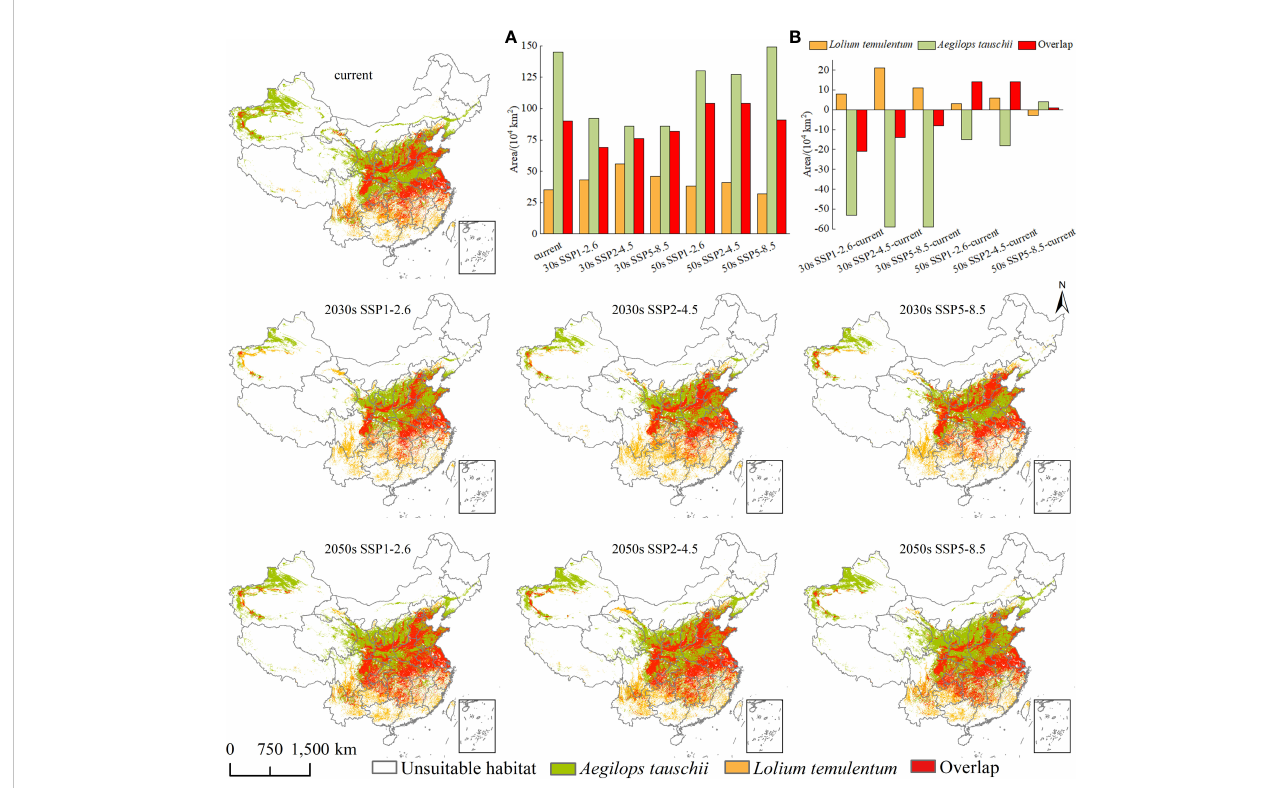
FIGURE 8 The niche overlap of Lolium temulentum and Aegilops tauschii under the current climate and future scenarios in the 2030s and 2050s, (A) the single plant and overlap areas, (B) the change of single plant and overlap areas from the current climate to the future